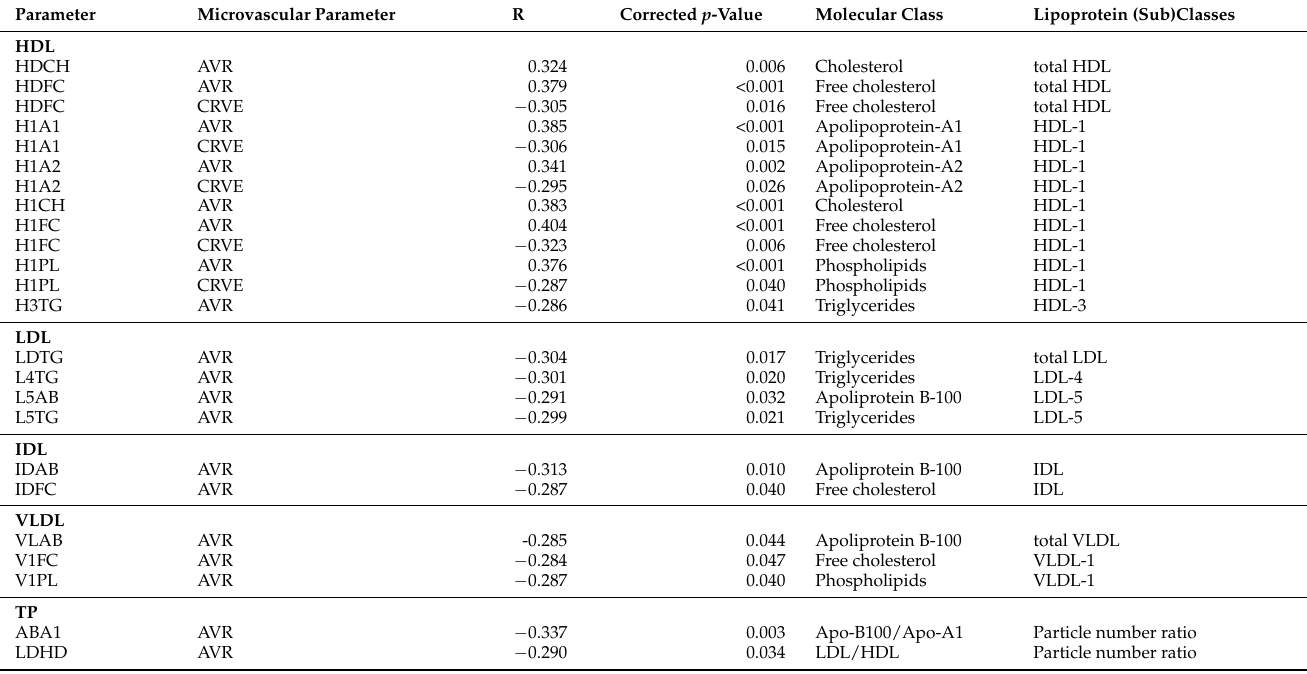
Table 2. Associations of lipoprotein subclasses and microvascular